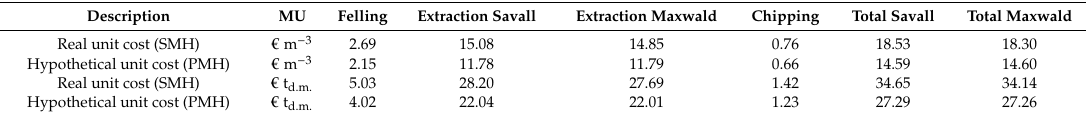
Table 10. Operation productivity and costs for single operation and total costs referred to one cubic meter or to one dry ton of wood from whole tree roadside.